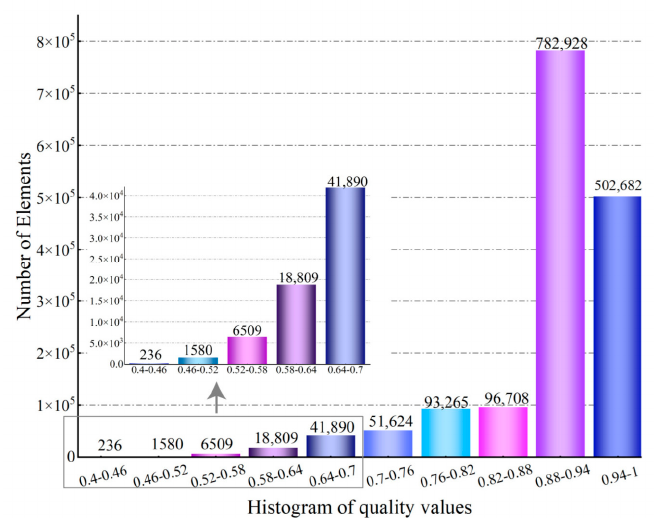
Figure 4. Variation of mesh quality with mesh numbers.